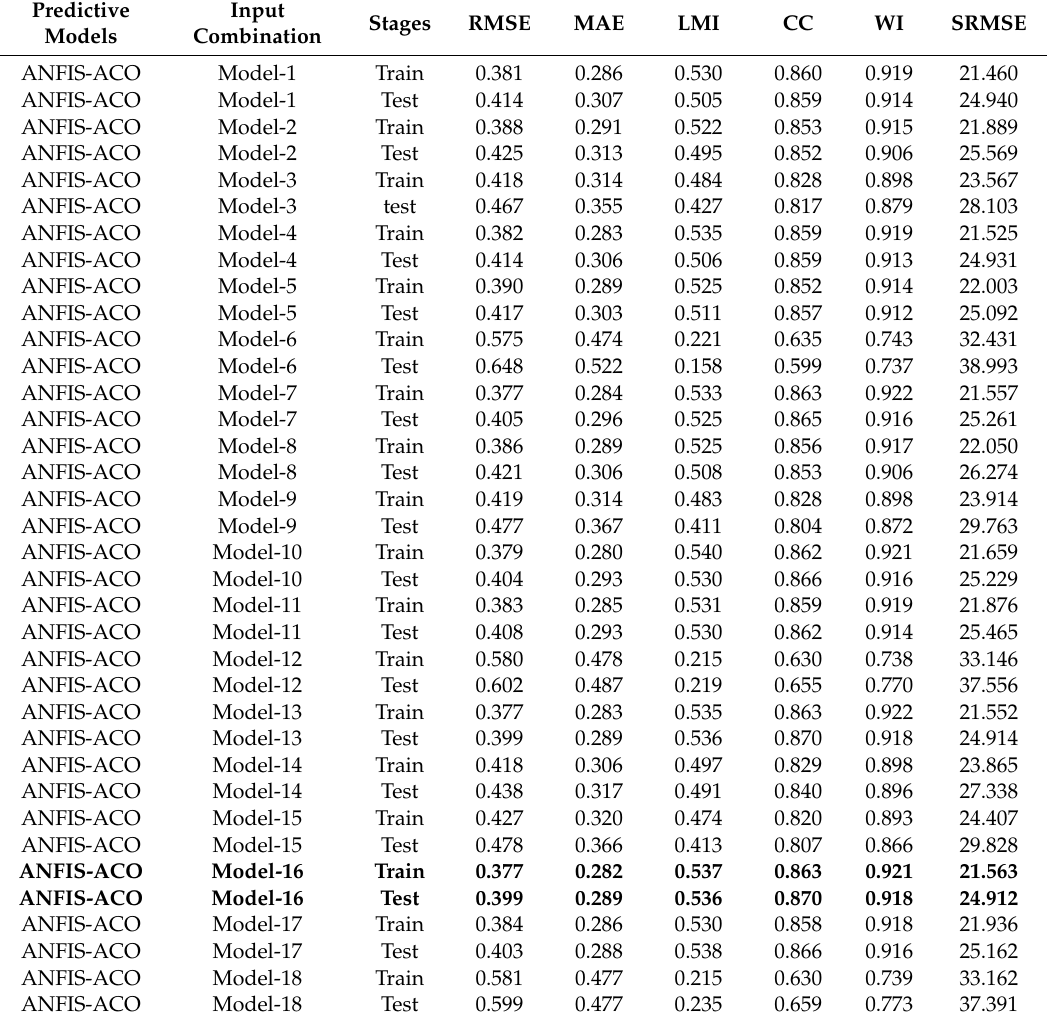
Table 3. The prediction performance of the hybrid ANFIS-ACO model for all proposed input combinations over the training and testing stage. The boldface denotes the best ANFIS-ACO model.